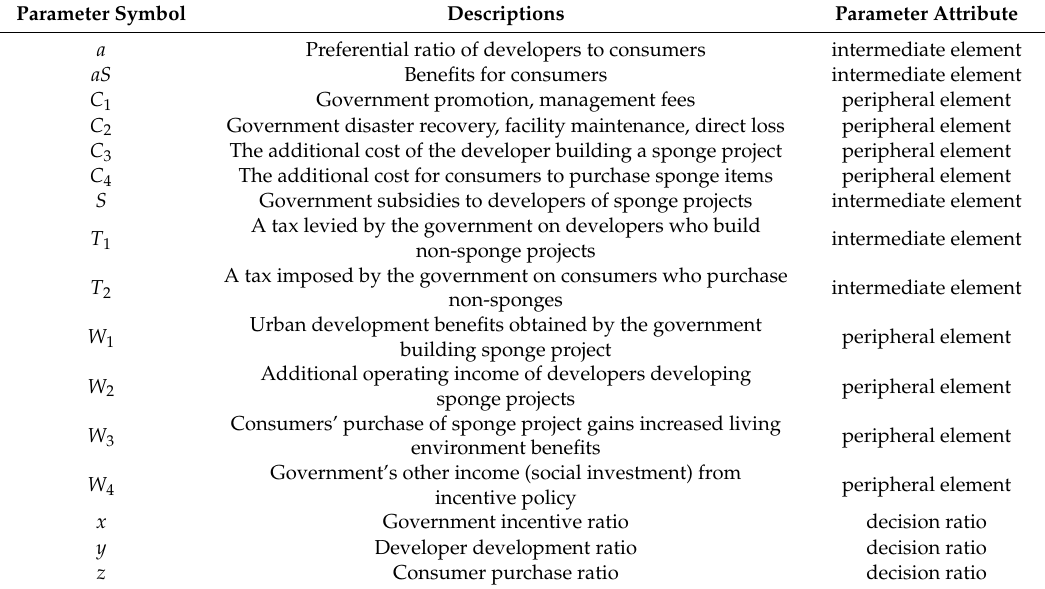
Table 1. Parameter definitions.